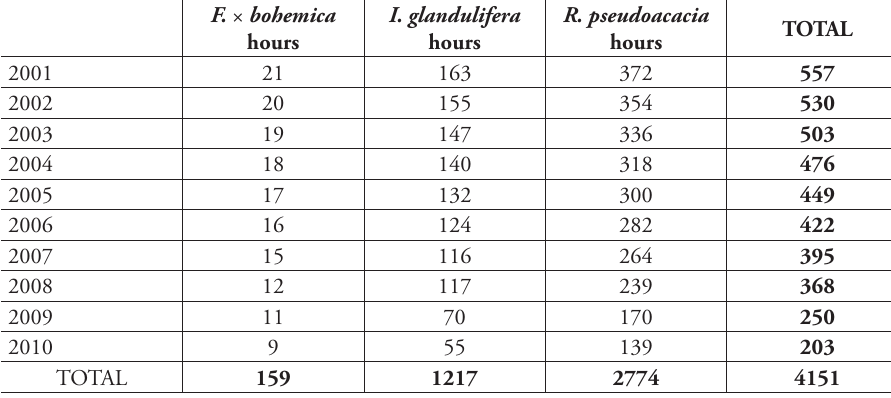
Table 1. Estimated annual working hours used for managing Fallopia × bohemica , Impatiens glandulifera and Robinia pseudoacacia in the Austrian part of the National Park Thayatal-Podyjí. Note that incomplete data on management effort for the years 2002-07 were interpolated (see main text for